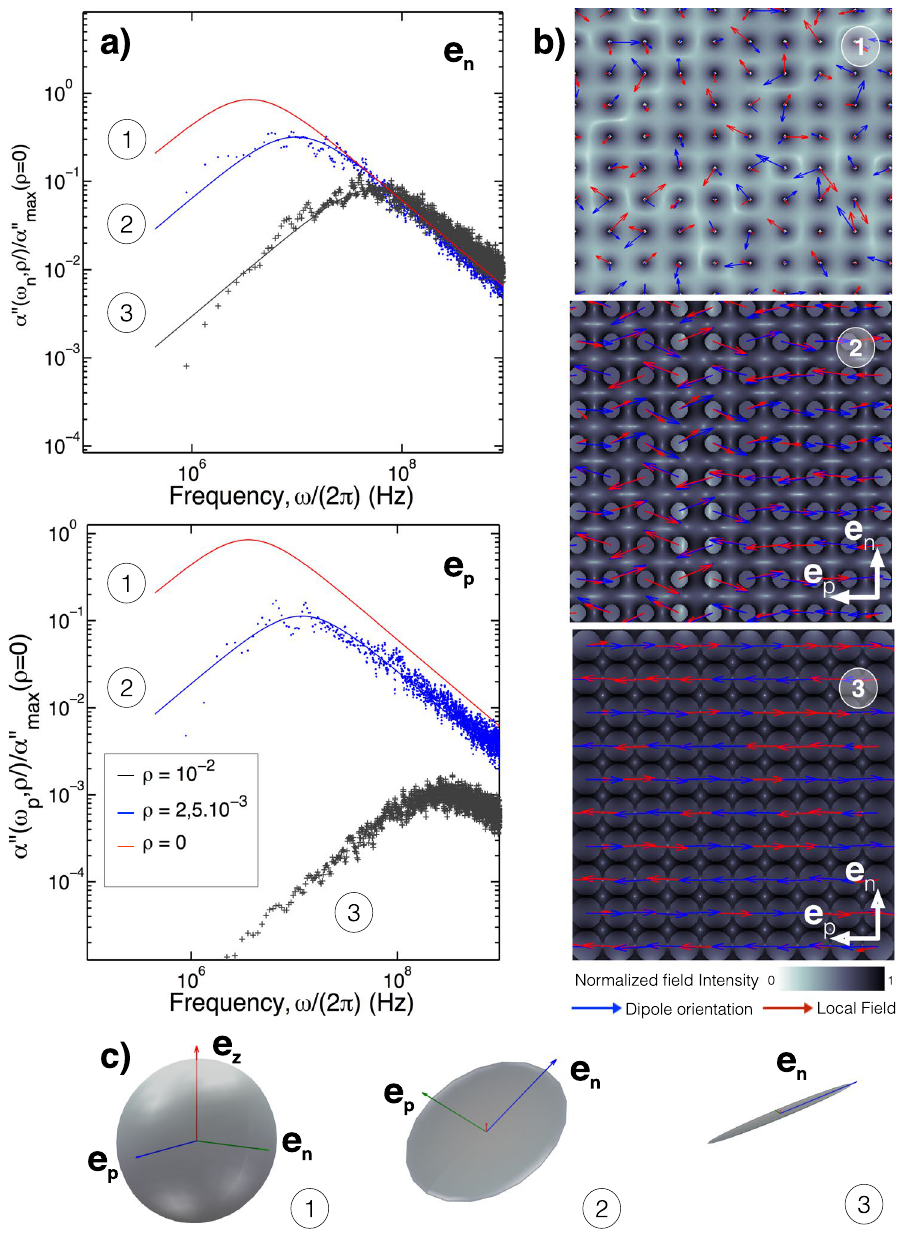
Figure 3. Susceptibility correlated with the local fields and dipole orientations. ( a ) Imaginary part of the in- plane magnetic susceptibilities α ″ and α ″ for the cases of no (1) ( ρ = 0 nm − 2 ), medium (2) ( ρ = 2.5 · 10 − 3 nm − 2 ) n p and strong (3) ( ρ = 10 − 2 nm − 2 ) interactions. ( b ) 2D mapping of the dipoles orientation (blue arrows), local fields induced by the interactions (red arrows) and local field intensity (grayscale). ( c ) Ellipsoidal representation of the static magnetic susceptibility tensor for the three